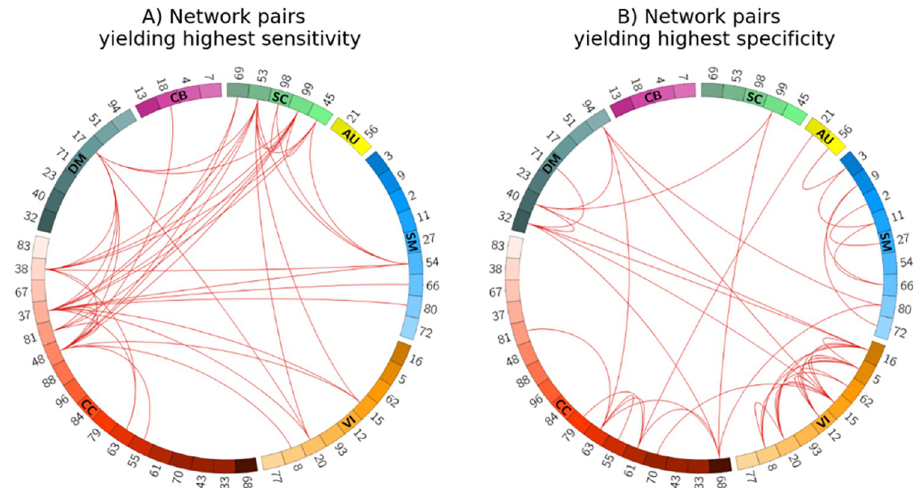
Fig 5. Spatial connectogram of sensitivity (A) and specificity (B) highlighting the top 2% network pairs. Sensitivity and specificity show the percentage of network pair samples correctly identified as the same- or different-subject cohorts, respectively. Fig 5A suggests that networks from the subcortical (green) and cognitive control (red) domains are among the most useful for characterizing same-subject samples, both intra- and inter-domain. On the other hand, the high specificity of VI-VI network pairs (orange) in Fig 5B indicates better characterization of different-subject samples. The numbers shown on the connectograms represent the specific Neuromark RSN network indices (See S1 Table for a list of the network names). The connectograms were generated using the Circos tool [51].